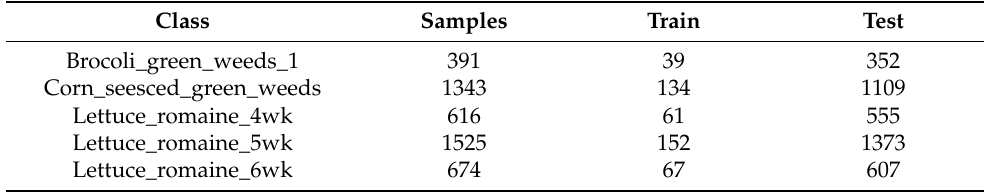
Table 1. Ground truth classes for the Salinas-A scene and their respective samples number.